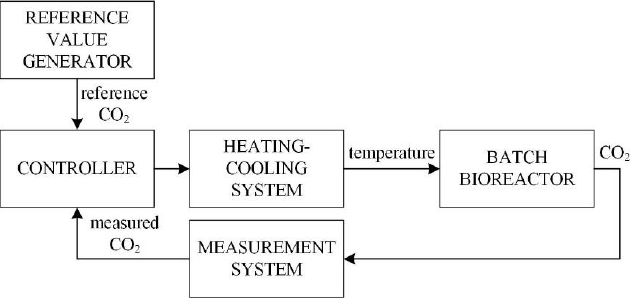
Figure 2. Block diagram of the control system for the fermentation process in batch bioreactors.